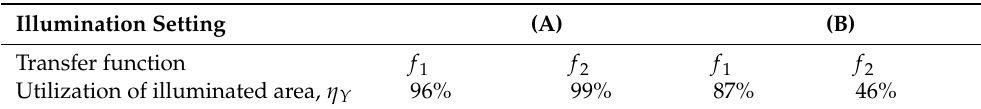
Table 3. Utilization of illuminated area ( η Y ) calculated for illumination settings ( A ),( B ) and for transfer functions f 1 and f 2